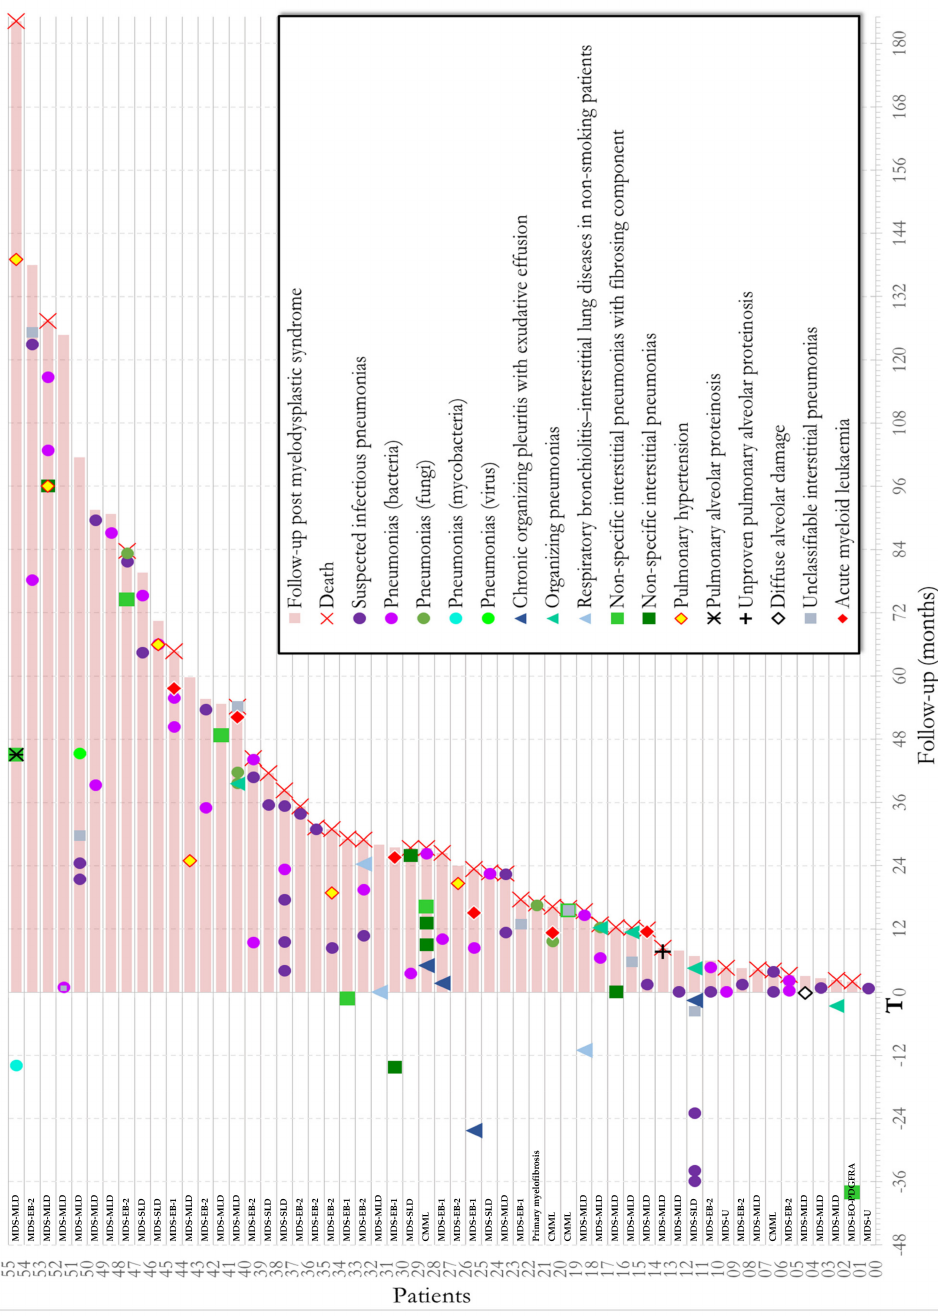
Figure 5. Historiogram of the cohort: chronology of pulmonary events in myelodysplastic patients. (T 0 : diagnosis of myelodysplastic